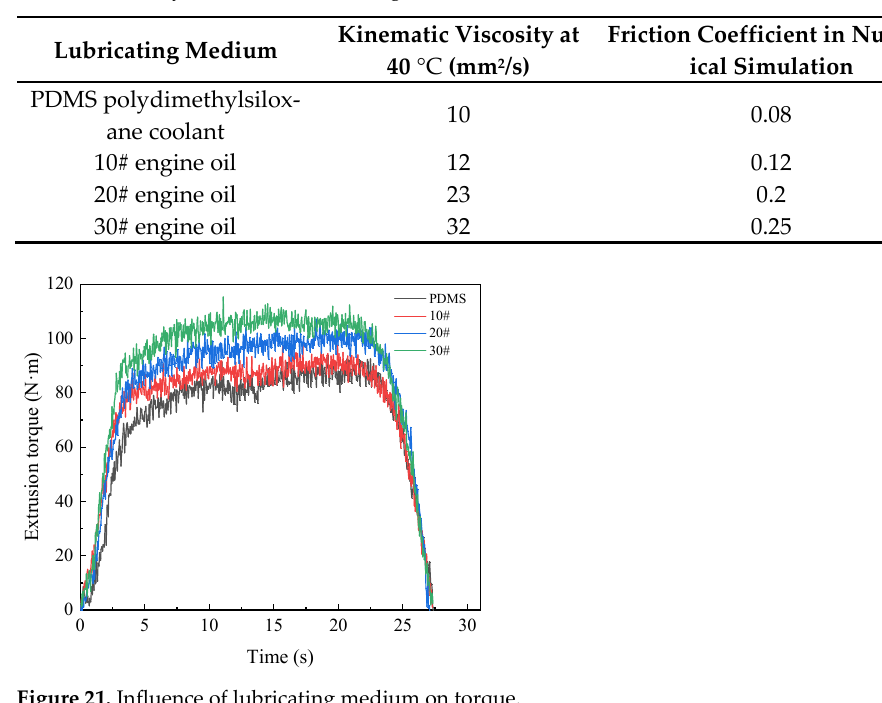
Table 1. Viscosity of different lubricating media and friction coefficients in numerical simulation.